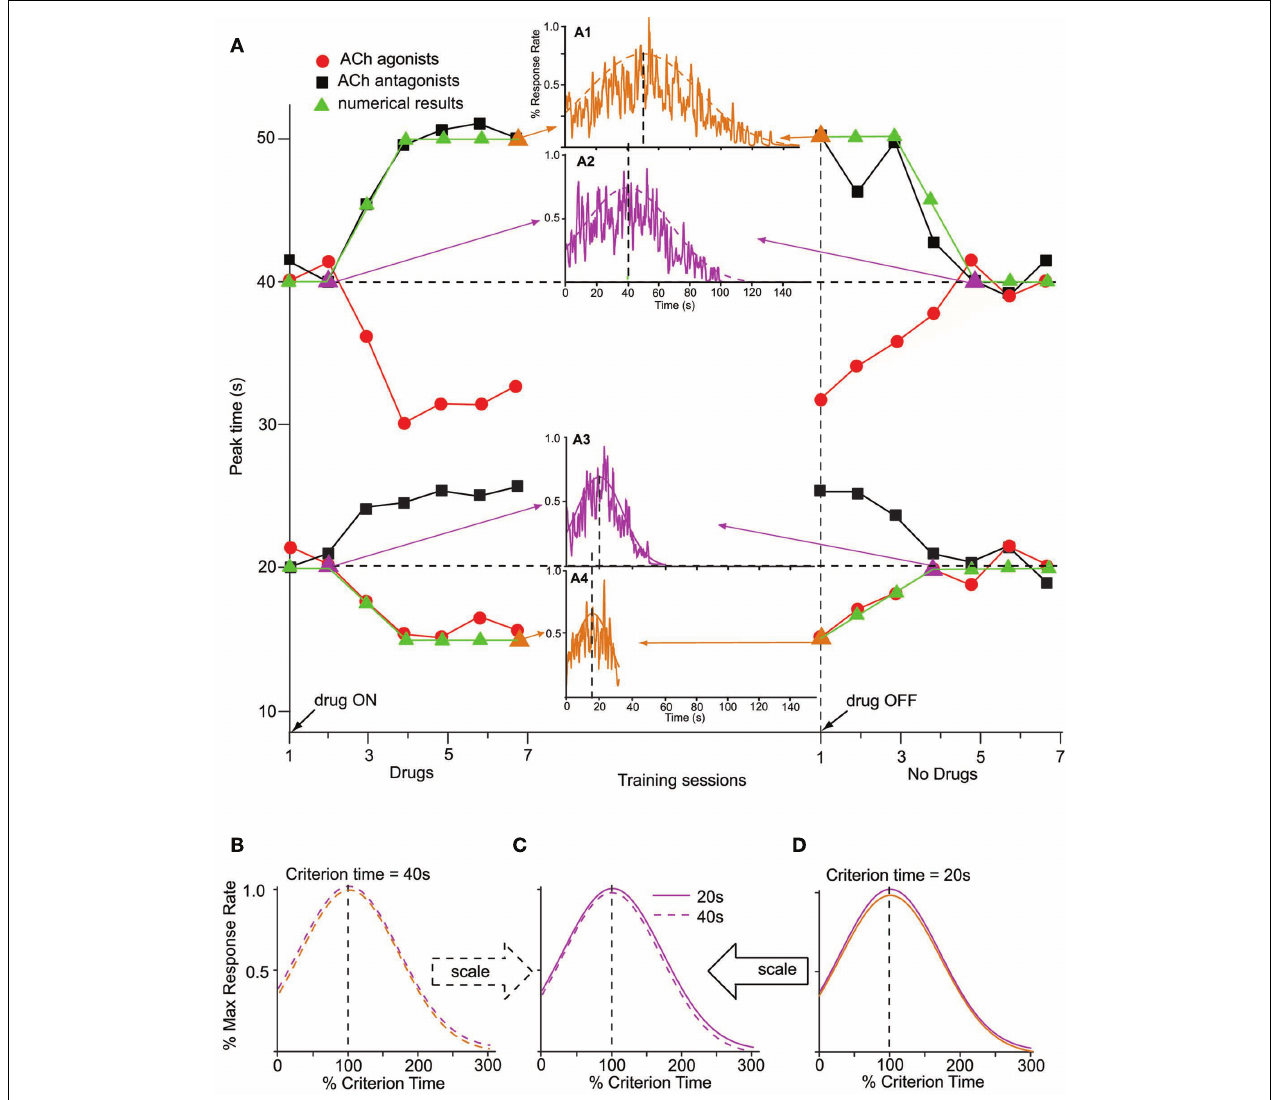
triangle symbol of the color of the inset). Insets: A1: gradual shift from T = 40 to T ∗ = 50s under atropine; A2: gradual recalibration upon discontinuing atropine; A3: gradual recalibration upon discontinuing physostigmine; A4: gradual recalibration under physostigmine.The dashed (A1,2) , respectively, continuous (A3,4) smooth lines represent Gaussian fits. (B) .The Gaussian fits (dashed smooth lines) in (A1,2) are given by Gauss (50, 33s), respectively, Gauss (40, 27s).Timing functions at different points of the memory pattern for T = 40s are time-scale invariant. (C) .Timing functions from the 20-s memory pattern and 40-s memory pattern are time-scale invariant. (D) .The Gaussian fits (continuous smooth lines) in (A3,4) are given by Gauss (20, 13s), respectively, Gauss (15, 10s).Timing functions at different points of the memory pattern for T = 20s are time-scale invariant. Colors match the insets. All Gaussian fits of numerical simulations gave COD > 0.9 and p < 0.0001.